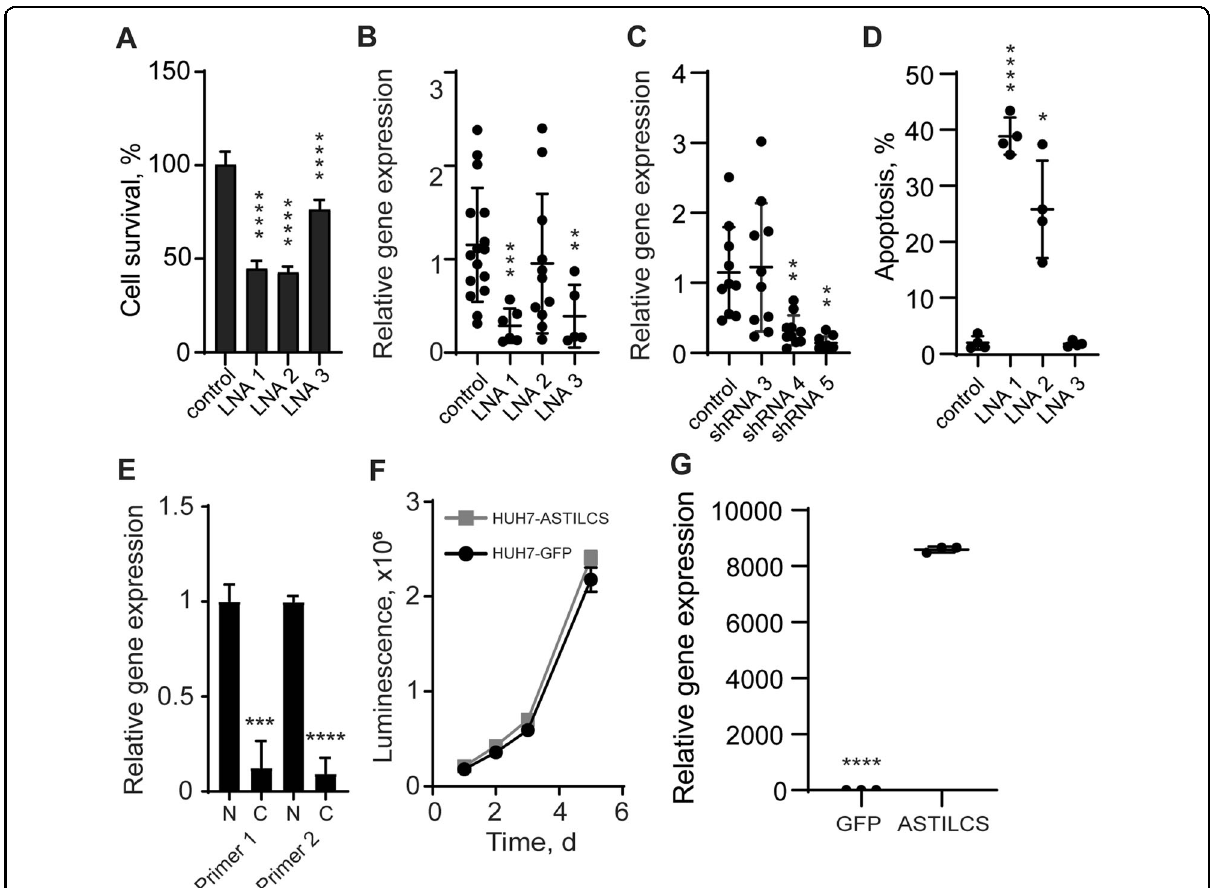
Fig. 3 ASTILCS expression is essential for liver carcinoma cell survival. A HUH7 cell survival 48 h after transfection with LNA gapmers targeting ASTILCS, n ≥ 6. B ASTILCS expression in HUH7 cells transfected with LNA gapmers targeting ASTILCS, n ≥ 5. C ASTICLS expression in HUH7 cells transduced with shRNAs targeting ASTILCS, n ≥ 5. D Apoptosis in HUH7 cells treated with LNA gapmers targeting ASTILCS, n = 3 . E ASTILCS expression in HUH7 cell nucleus and cytoplasm, n ≥ 8. F Growth curve for HUH7 cells transfected with GFP- or ASTILCS-expressing plasmids. G ASTILCS expression in HUH7 cells transduced with GFP- or ASTILCS-TRC209, n = 3. All values are mean ± SD, **** - p < 0.0001; *** - p < 0.001; ** - p < 0.01; * - p < 0.05; ns. - p >